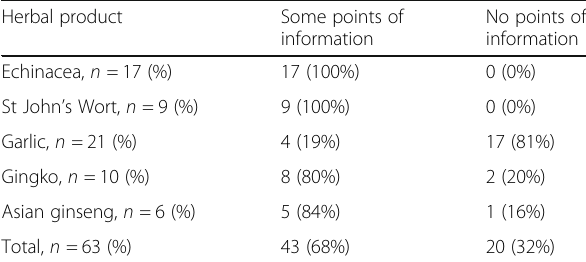
Table 7 Presence or absence of information points for each category of herbal product Herbal product Some points of